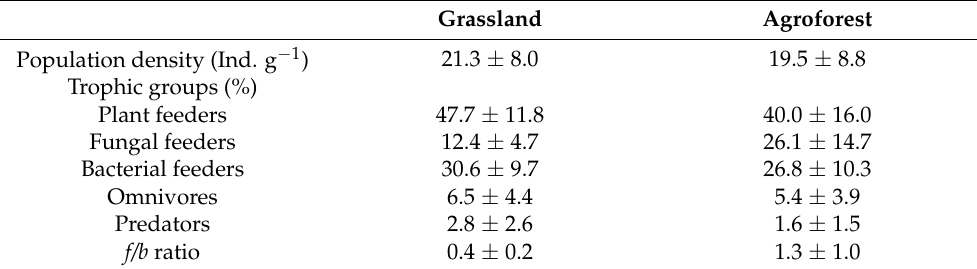
Table 1. Mean nematode population density [Ind. g − 1 DW ± s.d.], proportion of trophic groups [% ± s.d.] as well as the fungal to bacterial feeder ratio ( f/b ± s.d.) across all sampling days in grassland and agroforest soils.